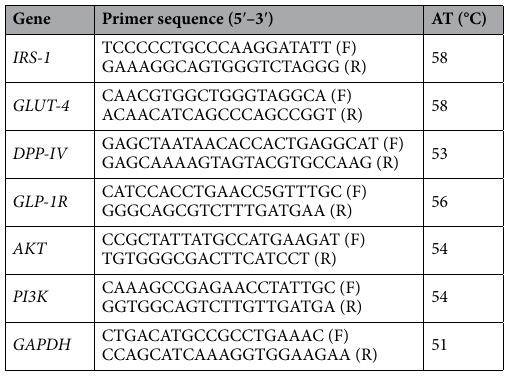
Table 1. Gene-specific primer sequence and RT-PCR parameter. AT, annealing